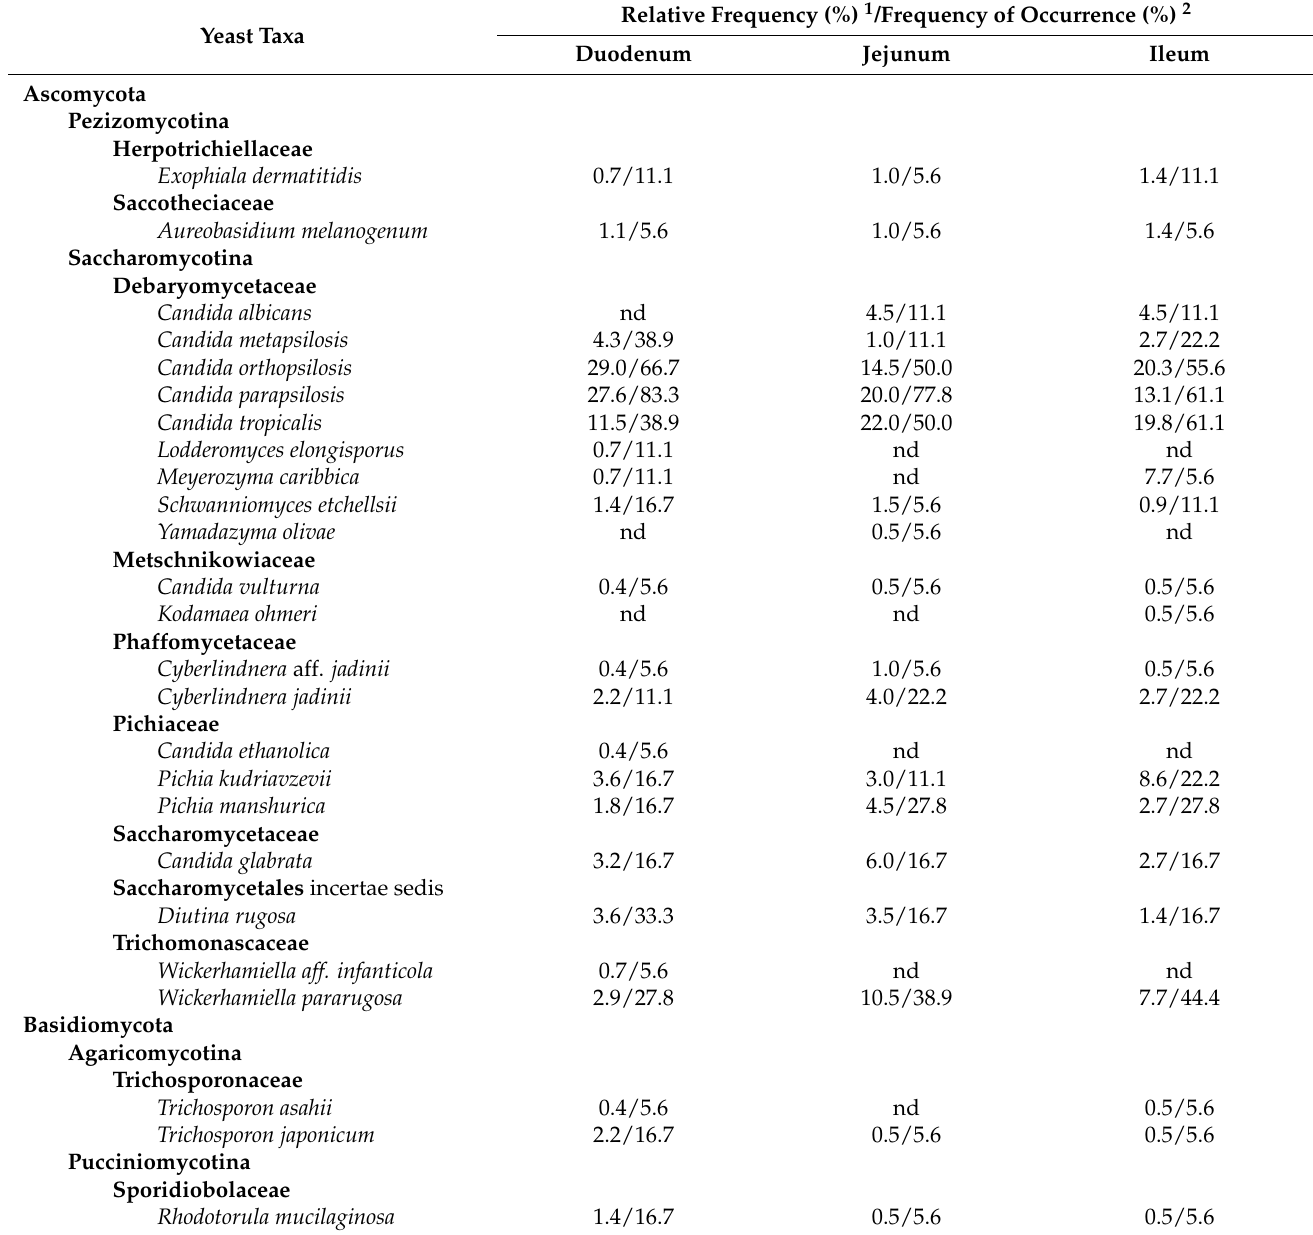
Table 3. Relative frequency and frequency of occurrence of yeasts isolated from pia